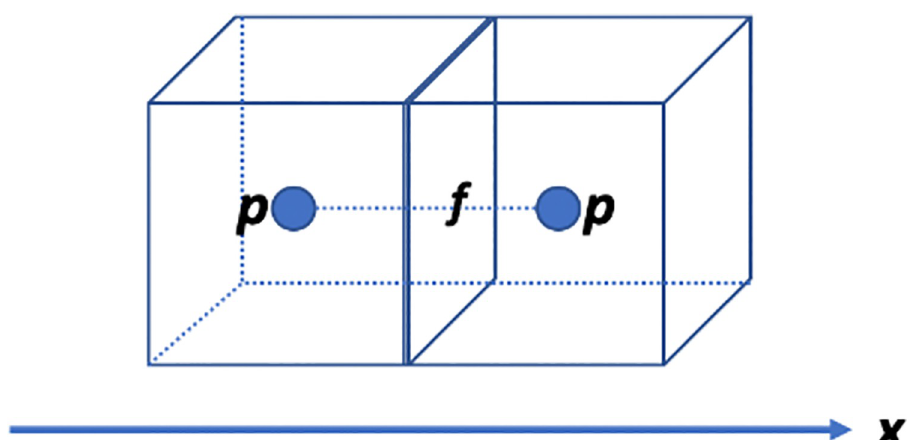
Fig 1. Discretization of the variable p in Eq (2). There are two cells in the x -direction. Suppose Eq (2) is discretized on the face f , and then the variable p is discretized at the center of the two cells, which is represented by the two solid